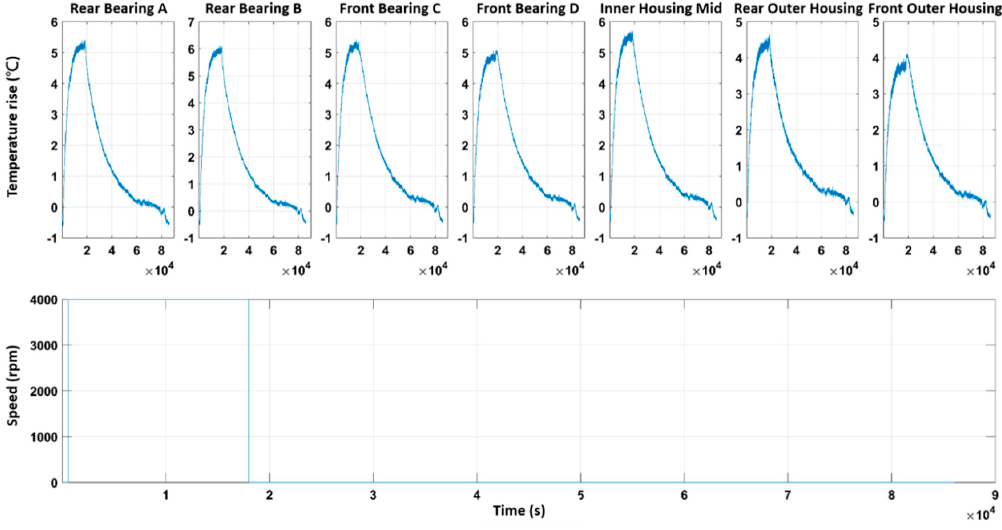
Figure 12. The final dataset for system identification. Given the case of 4000 rpm as an example.